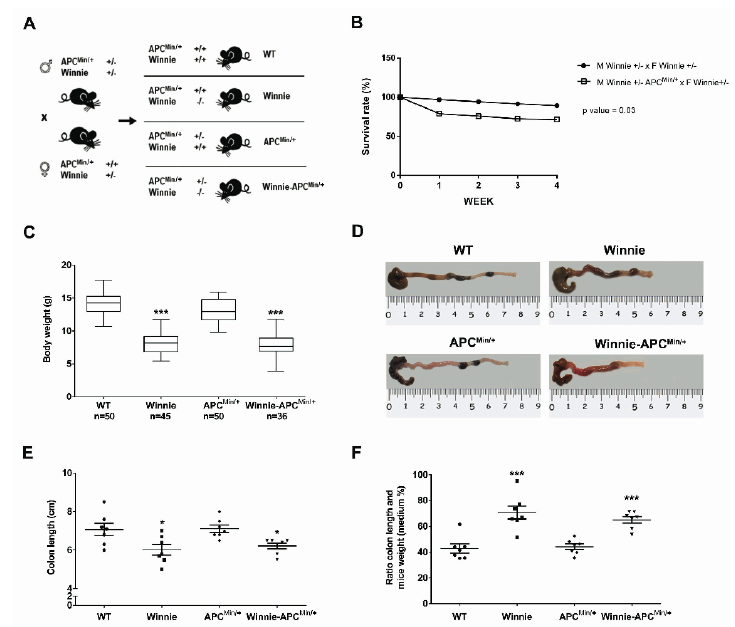
Figure 1. Creation and characterization of the Winnie- APC Min /+ murine model. ( A ) Breeding strategy used to obtain Winnie- APC Min /+ mice and the control littermates. ( B ) Impact of APC Min /+ mutation on survival rate in the breeding scheme of Winnie and Winnie- APC Min /+ mice. ( C ) Body weight analysis of 4-week-old Winnie- APC Min/+ mice and their relative controls. ( D – F ) Representative images of colon ( D ) and data analysis of colon length, and ( E ) colon length adjusted to body weight ( F ) for Winnie- APC Min/+ mice and control lines sacrificed at 5 weeks. E,F: n = 7 animals/group. * p < 0.05, *** p < 0.001 compared to WT mice.